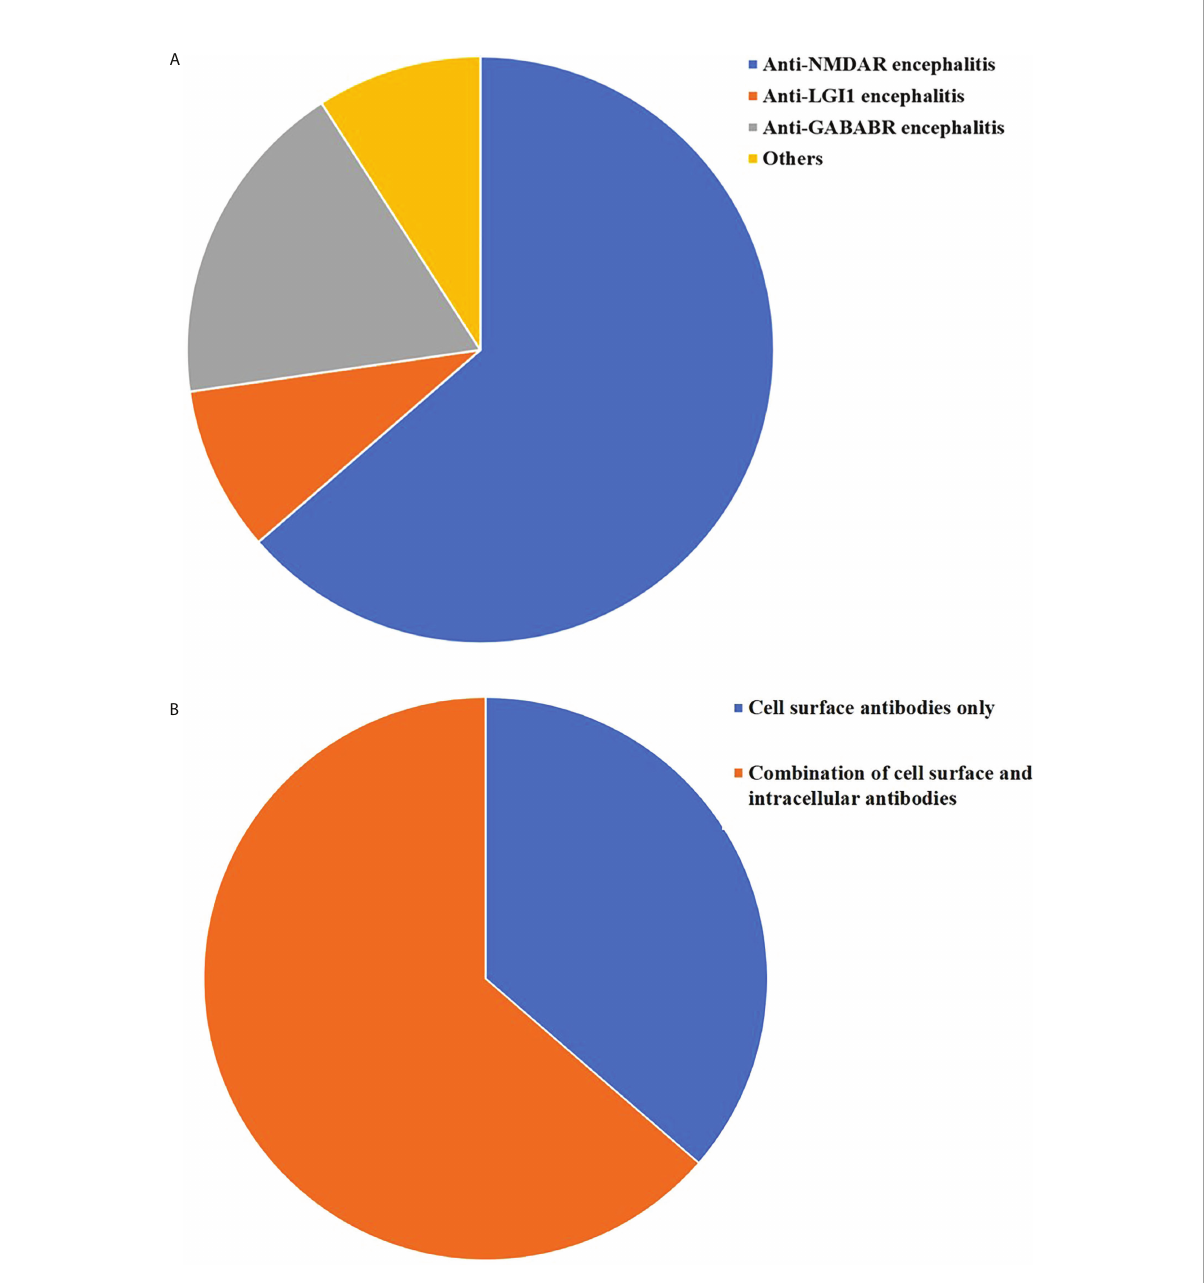
FIGURE 2 Distribution of overlapping anti-neuronal antibodies. (A) Proportion of different types of multiple anti-neuronal antibodies in 22 patients (B) Distribution of different types of anti-neuronal types in 22